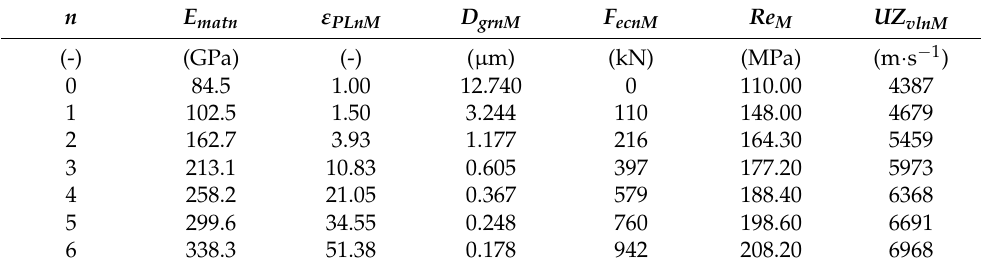
Table 1. Selected measured parameters for n = (cid:104) 0–6 (cid:105) , where E matn is the altered E mat .